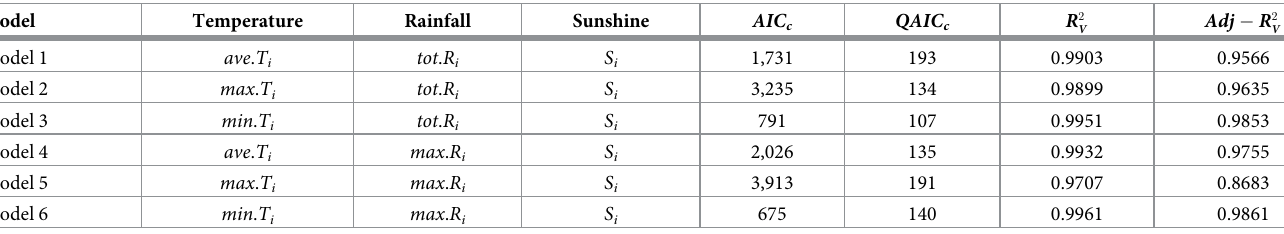
the criteria defined in Eq (2). For details of the stepwise AIC results, please refer to S2–S7 c Tables. In the second stage, LOOCV was conducted for the selected models. After LOOCV was performed, Model 3 was identified as the best prediction model, with the lowest mean squared error for the validation set, compared with Model 6 (0.29 vs 0.31; see Table 2). Model 3 was Table 1. Comparison of candidate models based on different evaluation